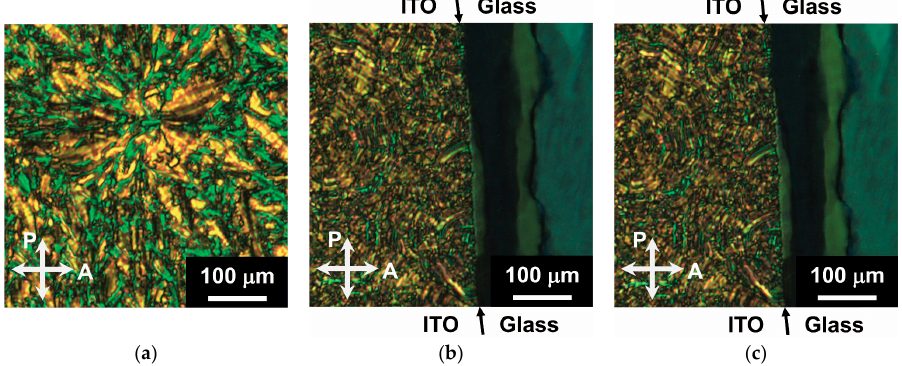
Figure 2. POM images of ( R )- 1 at ( a ) 140 °C, ( b ) 95 °C, and ( c ) 40 °C. The black arrows indicate the border of ITO electrode and glass surface.